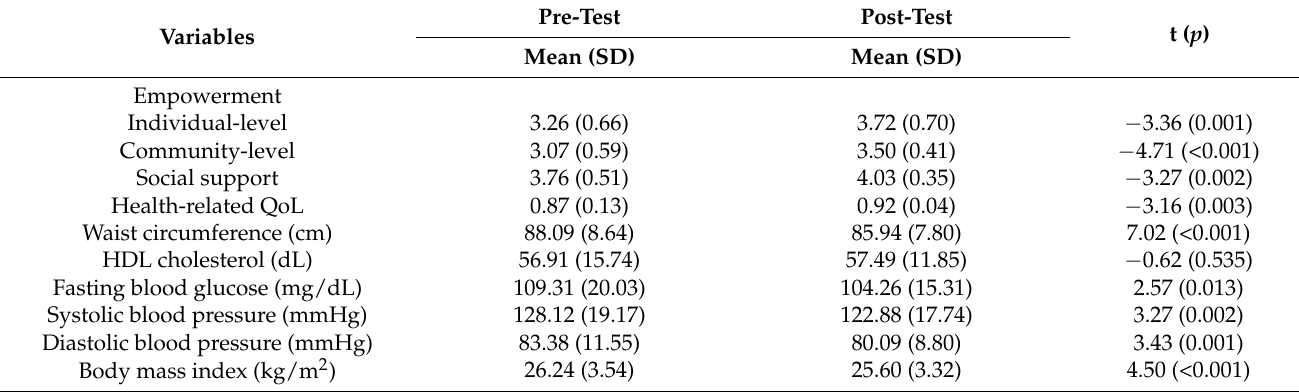
Table 3. Effects of the PAR program on the psychosocial factors and the metabolic-related indices ( N =